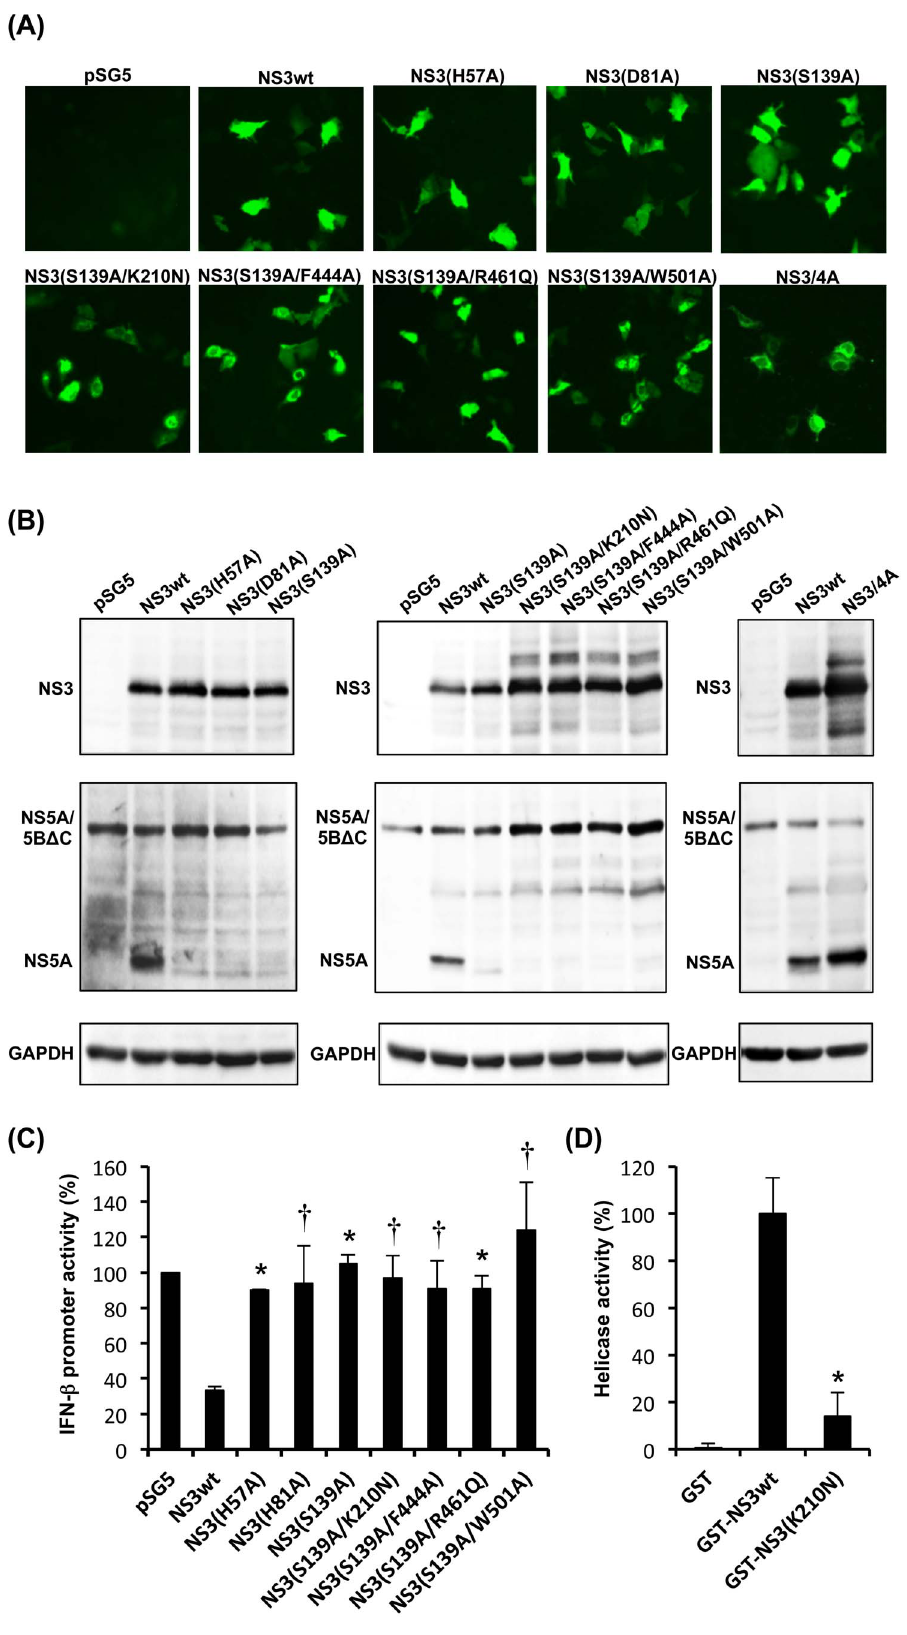
Figure 2. Analysis of NS3 expression, serine protease activity, effects on IFN- b promoter activity and RNA helicase activity. (A) Immunofluorescence analysis of NS3wt, various NS3 mutants and NS3/4A in Huh-7.5 cells transfected with the DNA vaccine candidates using anti-